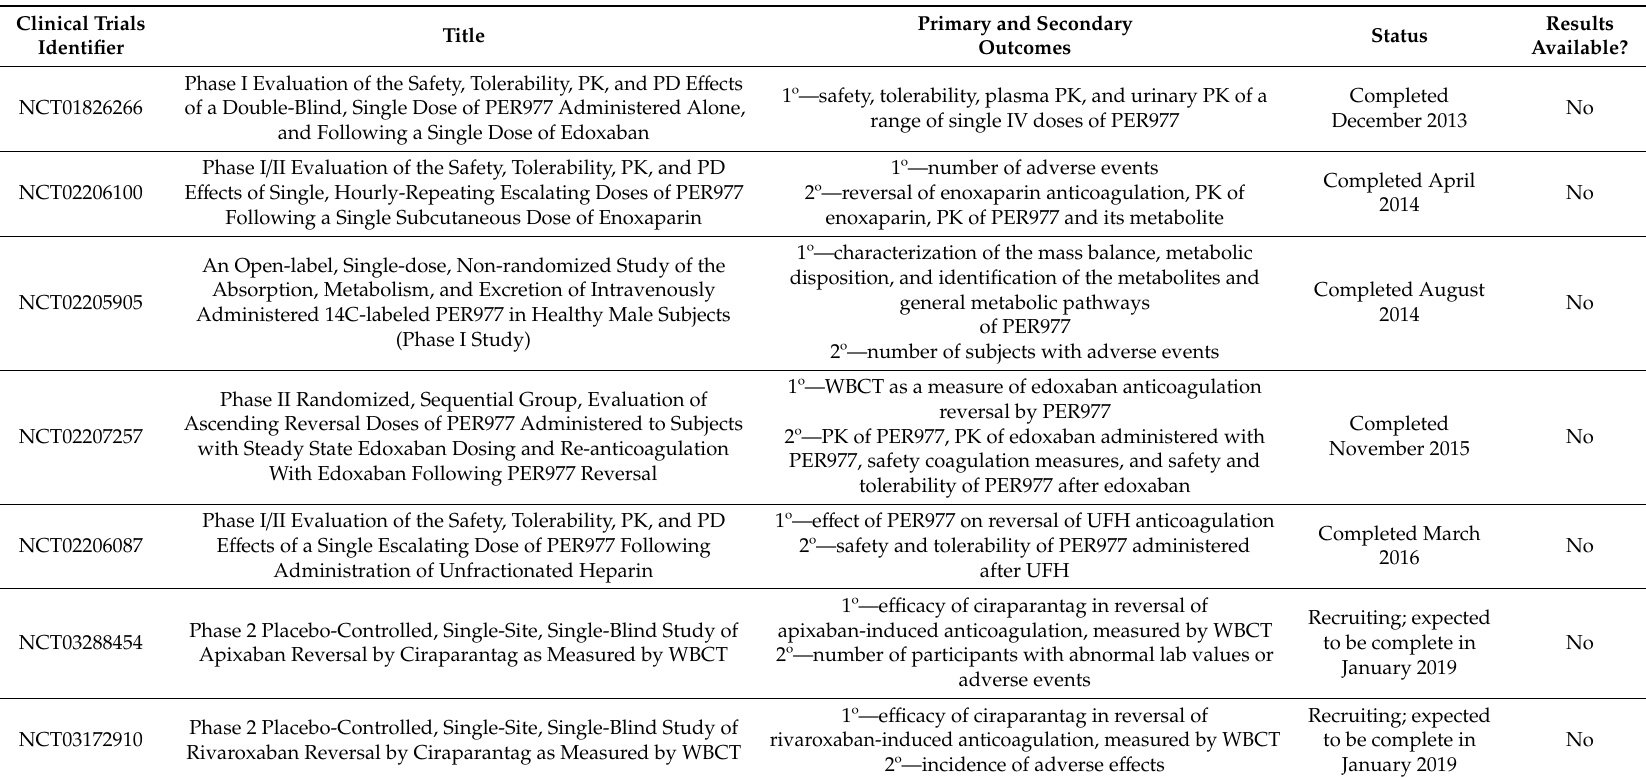
Table 3. Clinical trials studying